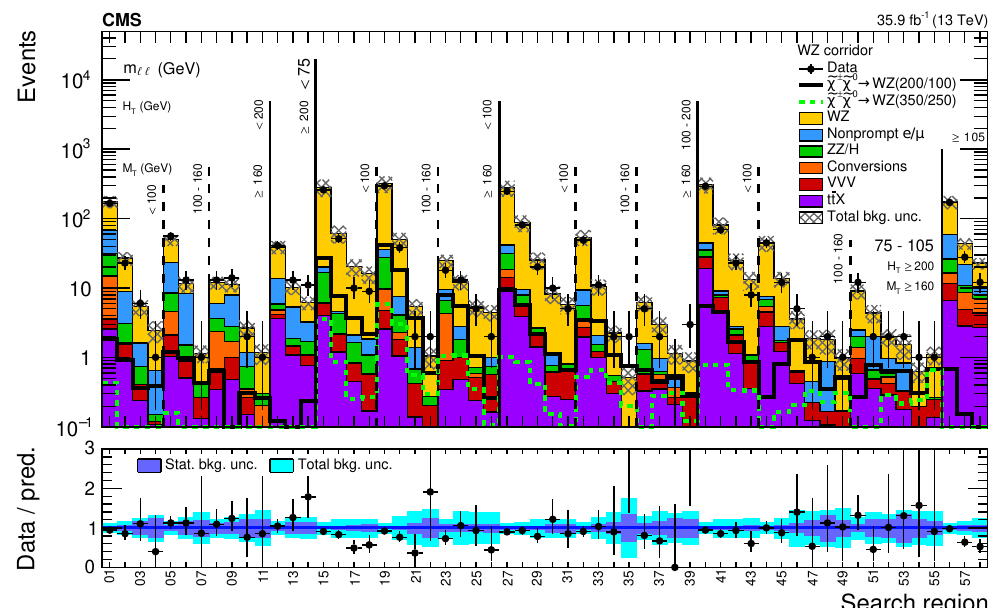
Figure 6 . Expected and observed yield comparison in the search regions. Two example signal mass points along the WZ corridor are overlaid for illustration. The mass values for the signal points are given as ( m =m ) in GeV. The bottom panel shows the ratio of observed data to predicted e (cid:31) 0 2 e (cid:31) 0 1 yields. The dark purple band shows the statistical uncertainty in the background prediction, while the light blue band shows the total uncertainty.